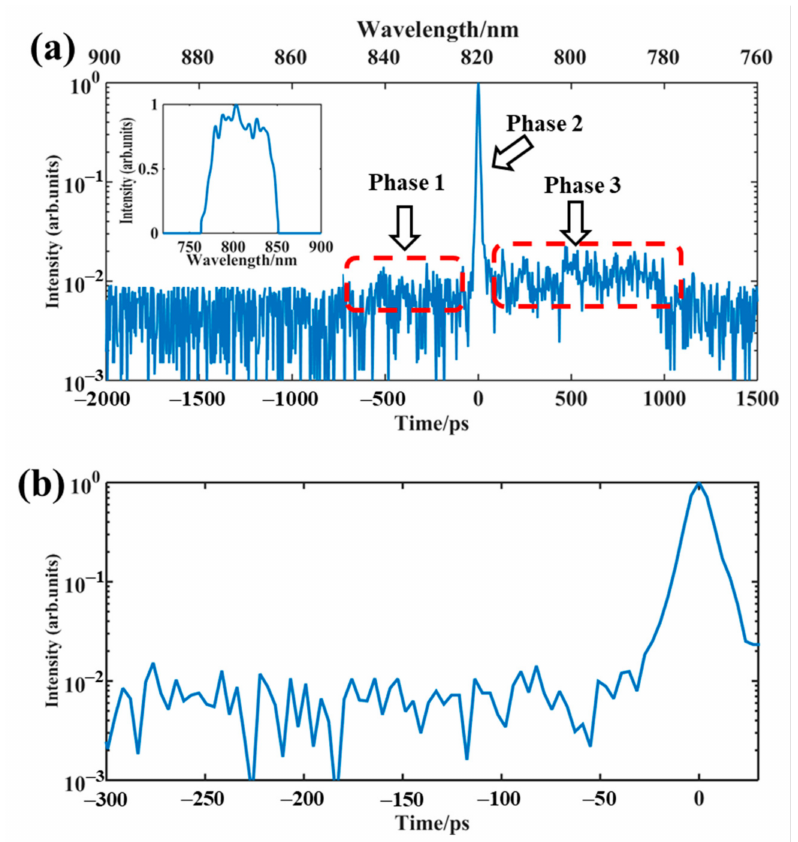
Figure 3. Single-shot temporal contrast enhancement measurement results of a plasma mirror: ( a ) Spectrum of SOCP after PM with original spectrum subtracted. The original spectrum of SOCP is in the upper left region of Figure 3a. ( b ) Temporal profile ranges from 300 ps to 30